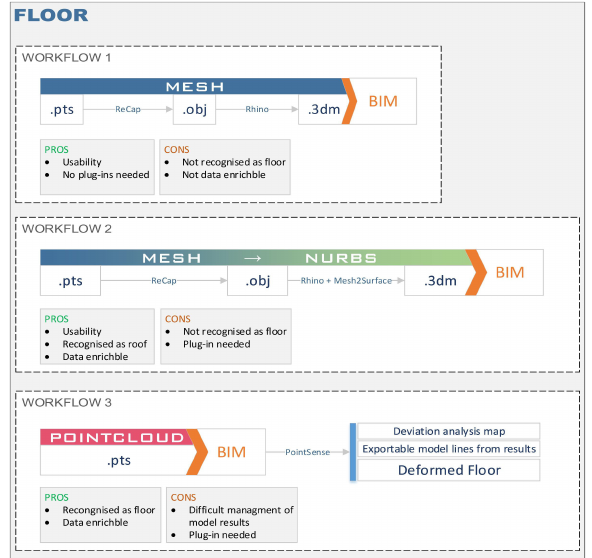
Figure 11. Synthetic schema that shows the results of the 3 workflows on the floor in terms of pros and